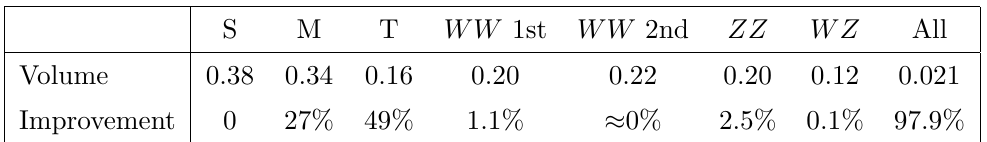
Table 3 . Similar to table 2, but for all linear, quadratic and quartic conditions. The S, M, and T column represent the linear conditions in S -, M - and T -subspaces, while the next four columns represent quadratic and quartic conditions as in table